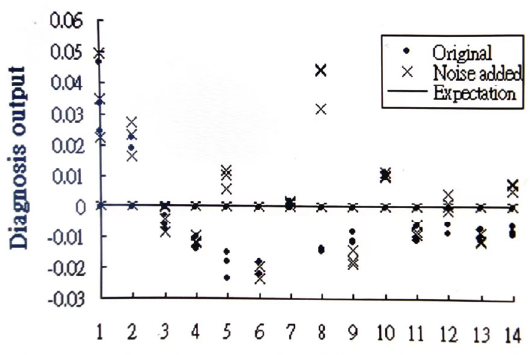
Figure 8. The output of non − detection for robustness test.